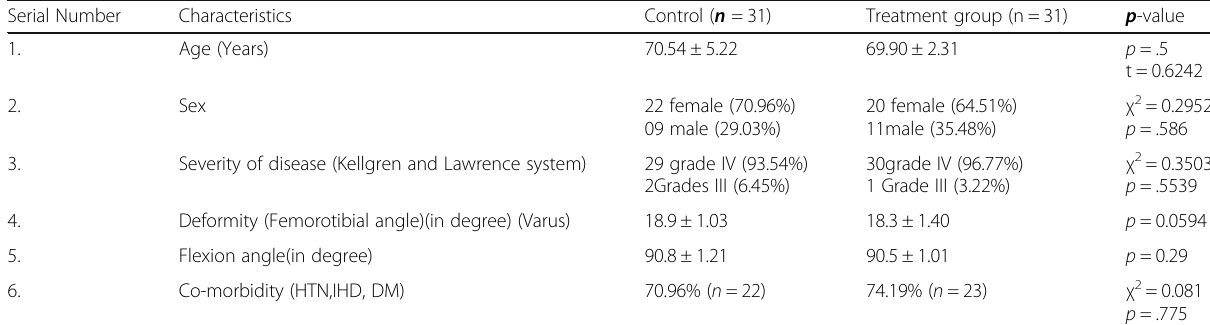
Table 1 Patient demographics and preoperative characteristics